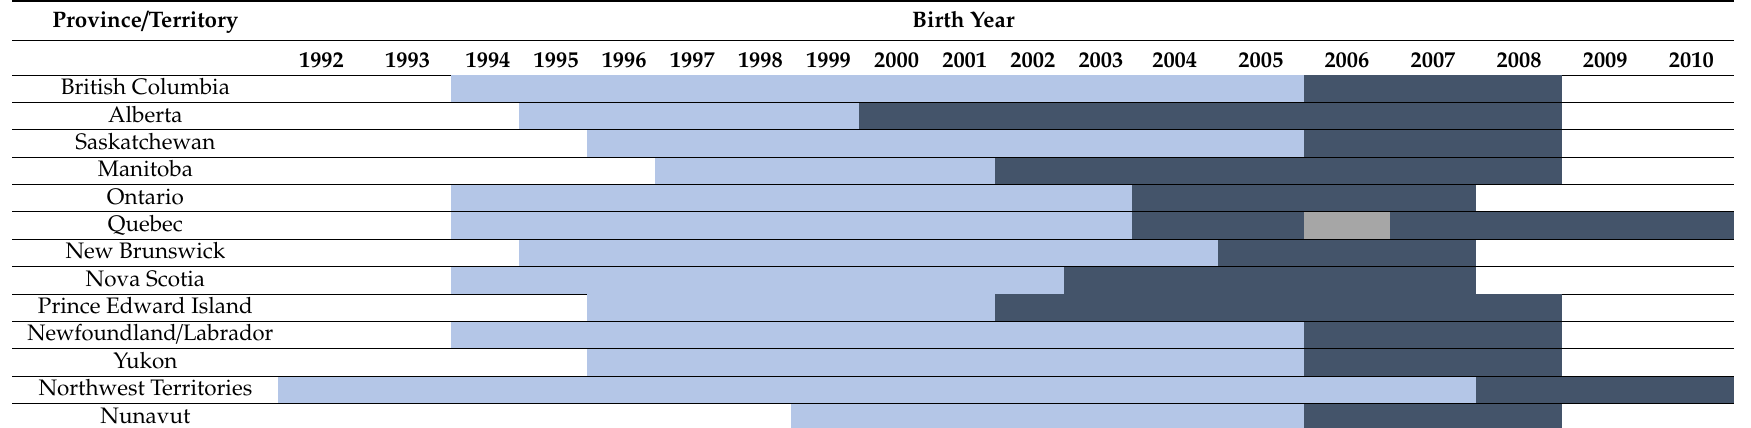
Table 3. Birth years of children that have been eligible for school-based HPV vaccination programs (as of end of 2019 / 20 school year). Province / Territory